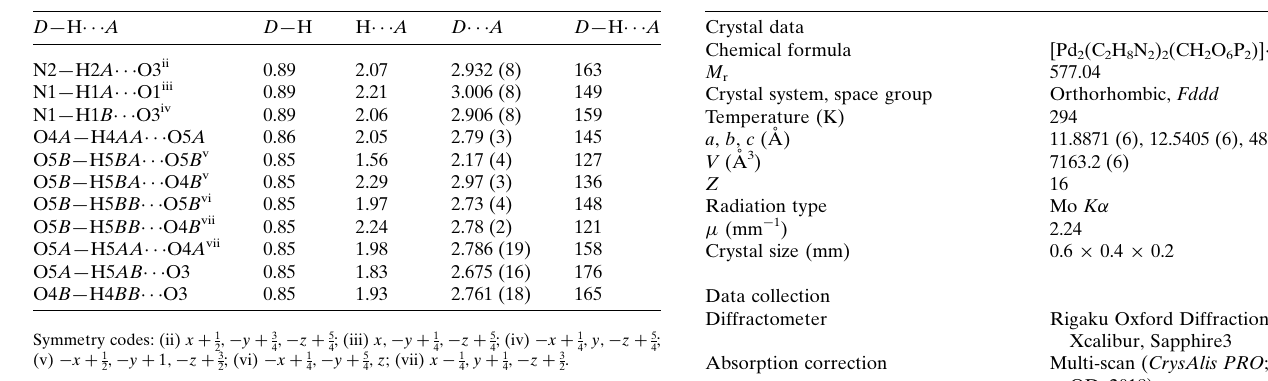
Table 2 Hydrogen-bond geometry (A˚ , (cid:3) ).